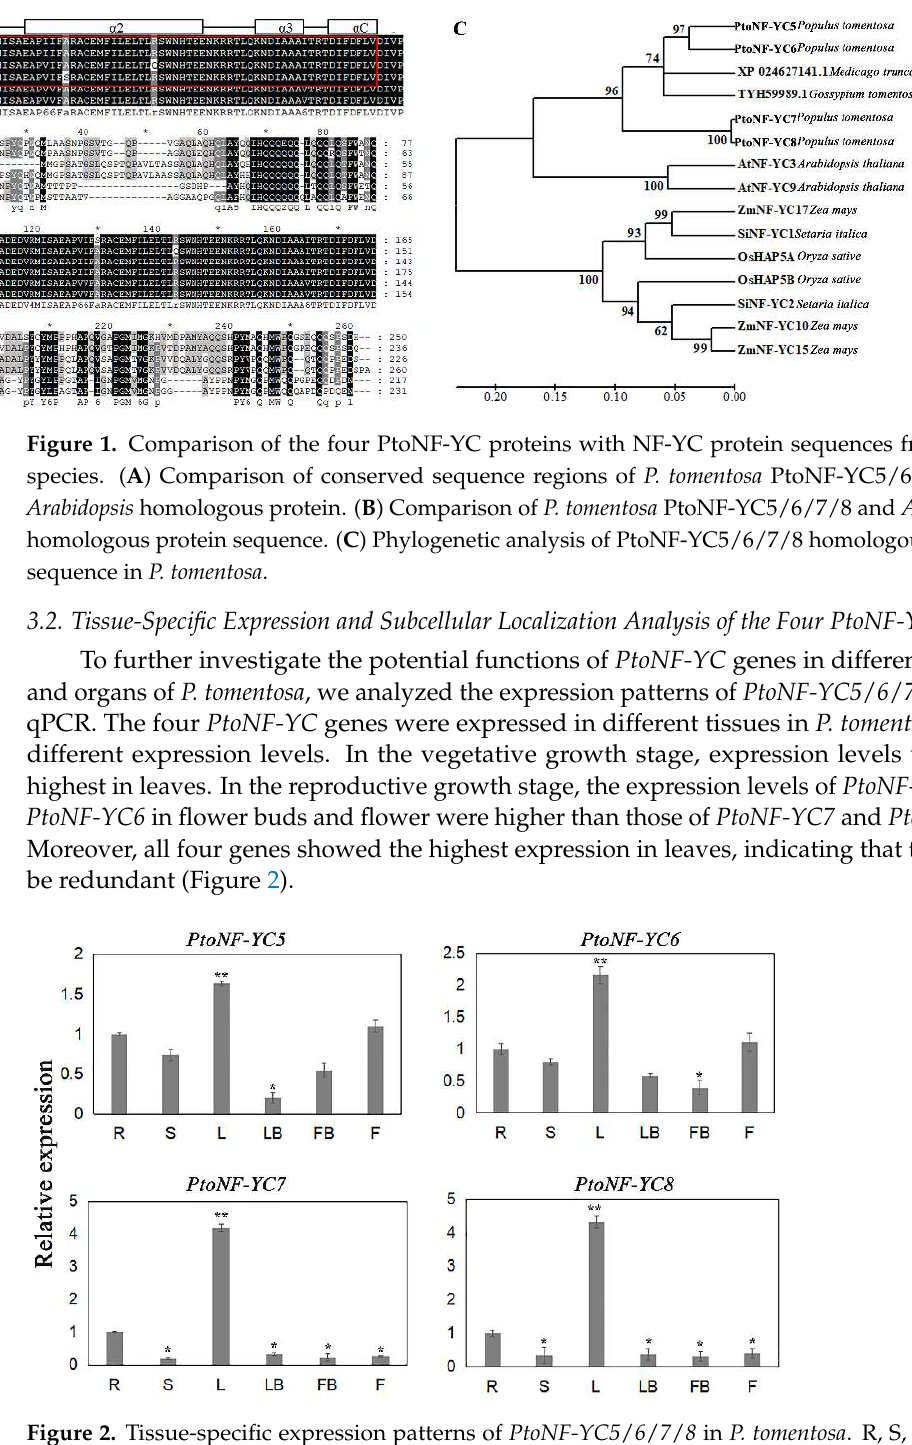
Figure 2. Tissue-specific expression patterns of PtoNF-YC5 / 6 / 7 / 8 in P. tomentosa . R, S, L, LB, FB, and F represent roots, stems, leaves, leaf buds, flower buds, and flowers, respectively. The data was presented as mean ± SE (n = 3 independent replicates), * ( p < 0.05) and ** ( p < 0.01) indicate significant differences.